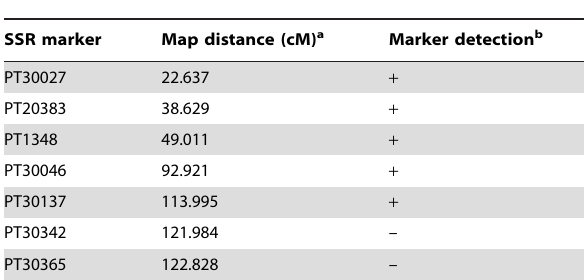
Table 5. Analysis of a Haplo-Q 6 N. africana hybrid with a possible deletion of the Q chromosome segment using SSR markers on linkage group